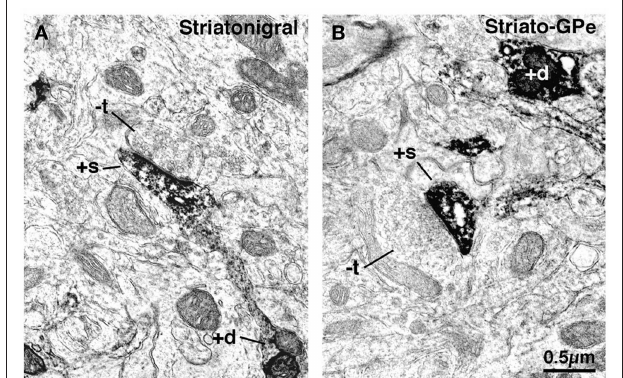
Figure 5 | electron microscopic images of dendrite ( + d) and spine ( + s) labeling of striatonigral (A) and striato-gPe (B) neurons that had been retrogradely labeled with BDA3k from their target areas. Note that striatonigral (A) spines receive asymmetric synaptic contact from smaller unlabeled terminals ( − t) than do striato-GPe neuron spines (B)